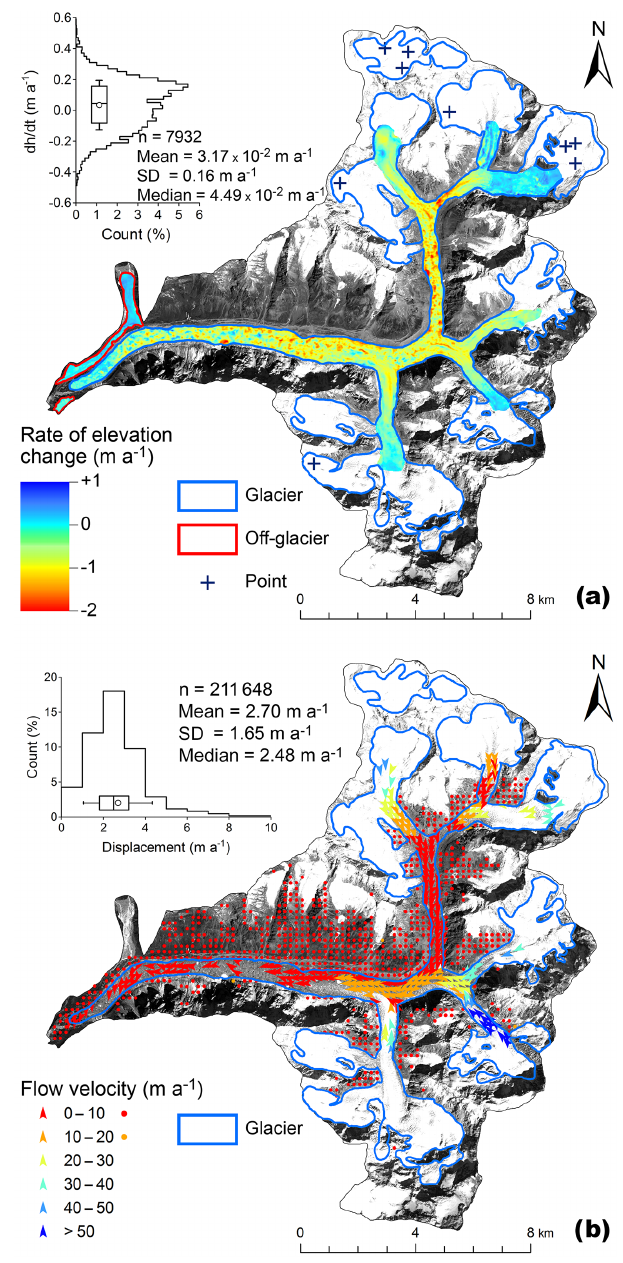
Figure 2. (a) Rate of elevation change for the 1975–2010 study pe- riod and (b) ice-flow velocity between March 2010 and December 2010 for Kanchenjunga Glacier. The elevation difference (a) and displacement (b) in the ice-free terrain were used to evaluate the uncertainties of the two DEMs and ice-flow velocity (inset graphs). The black crosses in (a) denote the point measurements of eleva- tion change in the upper accumulation area. The vectors and points in (b) are depicted at a 200m spatial interval for better visibility. The box, thick line, circle, and whiskers in the inset graphs denote the interquartile, median, mean, and 1 standard deviation, respec- tively.